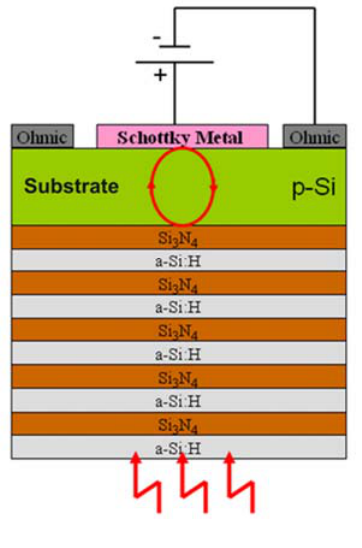
Figure 17. Schematic cross section of the photodetector proposed by Casalino et al. [72,73]. Reprinted with permission from M. Casalino et al. Copyright © 2010